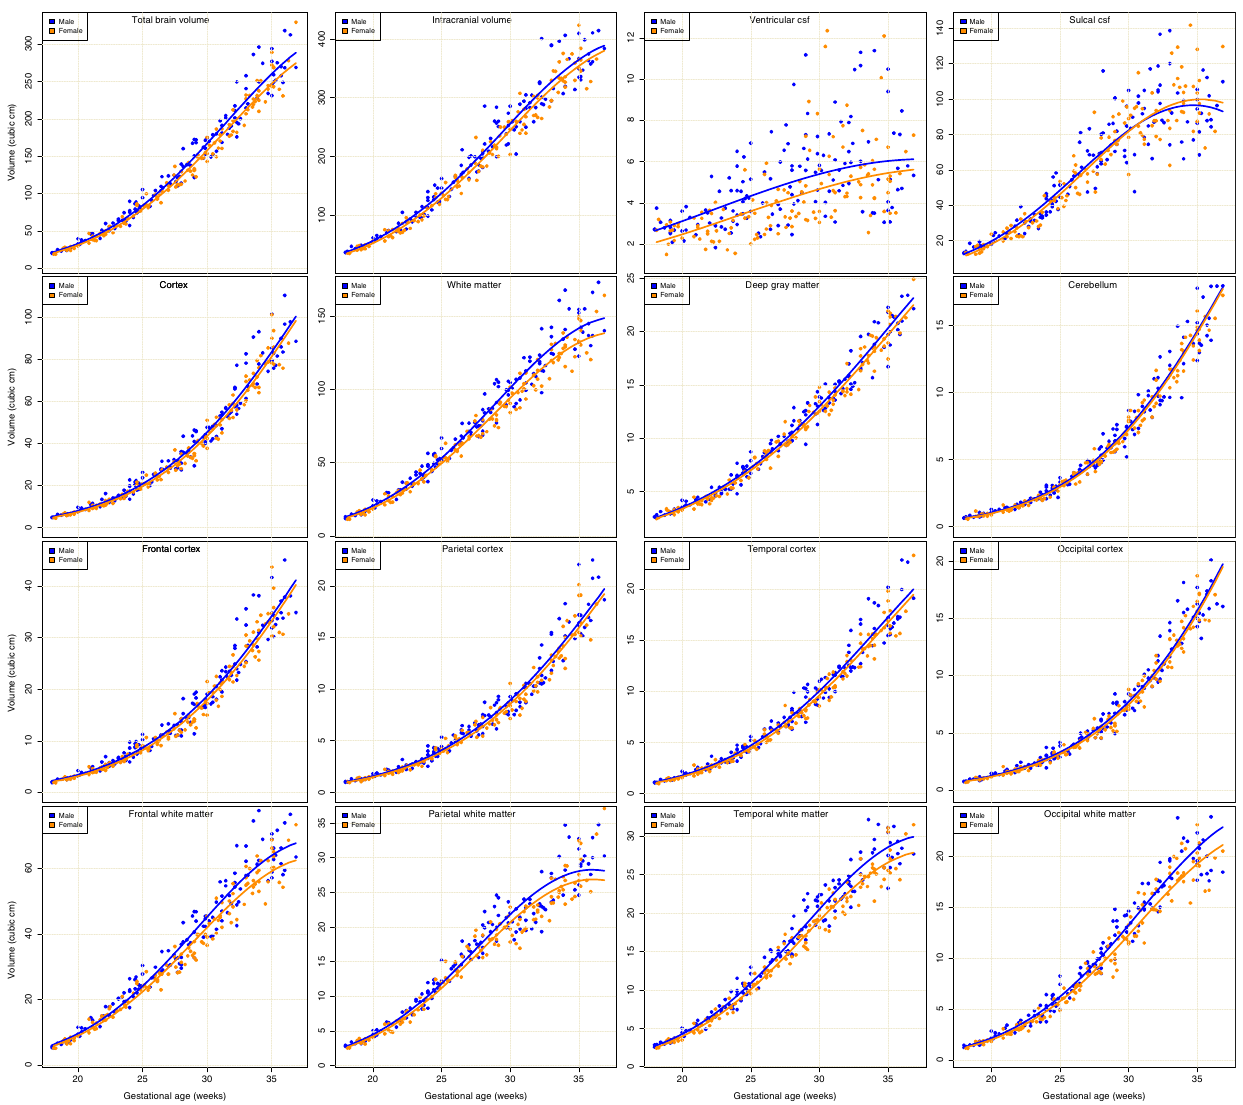
Fig. 2 Plots of global and lobar absolute volume measures against age. Measures for male and female fetuses together with the fi tted models in each class transformed to measurement units for visualization. Non-linear growth trajectories over the 18 weeks are apparent for all the measures. Differences in male and female measures are apparent and increase with age, but analysis shows that this difference follows a constant fractional ratio between male and female (see Table 1). The smallest sex differences in tissues are seen in the cerebellum volumes, which do not reach statistical signi fi